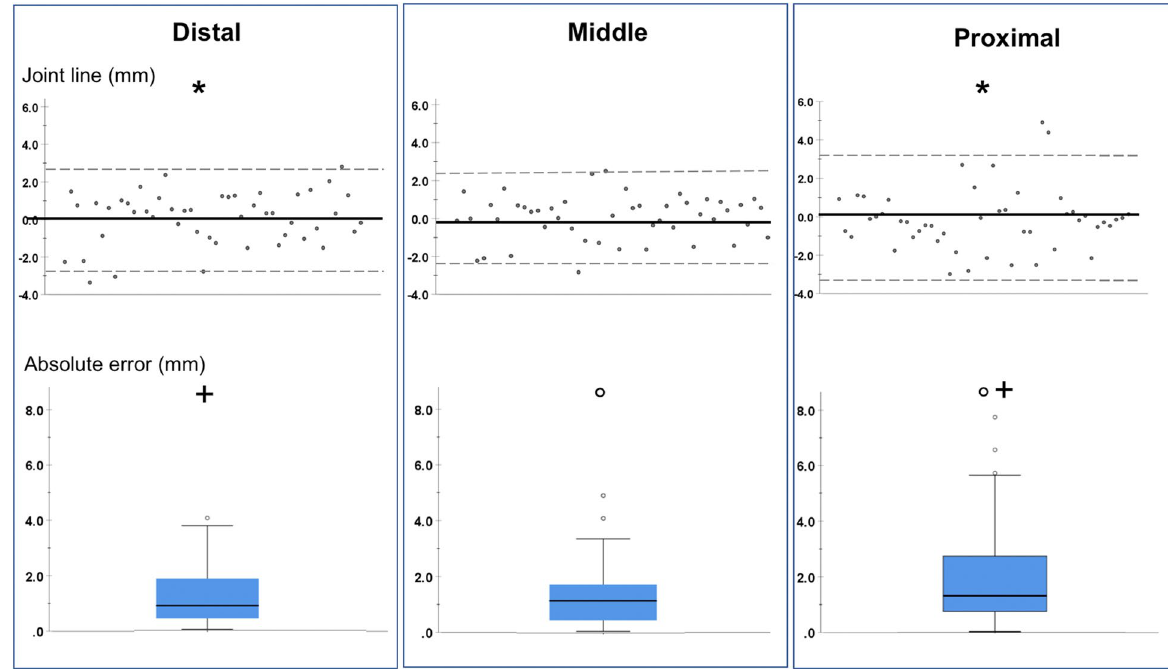
Fig. 5 Joint line approximation and absolute error among the distal, middle, and proximal segment